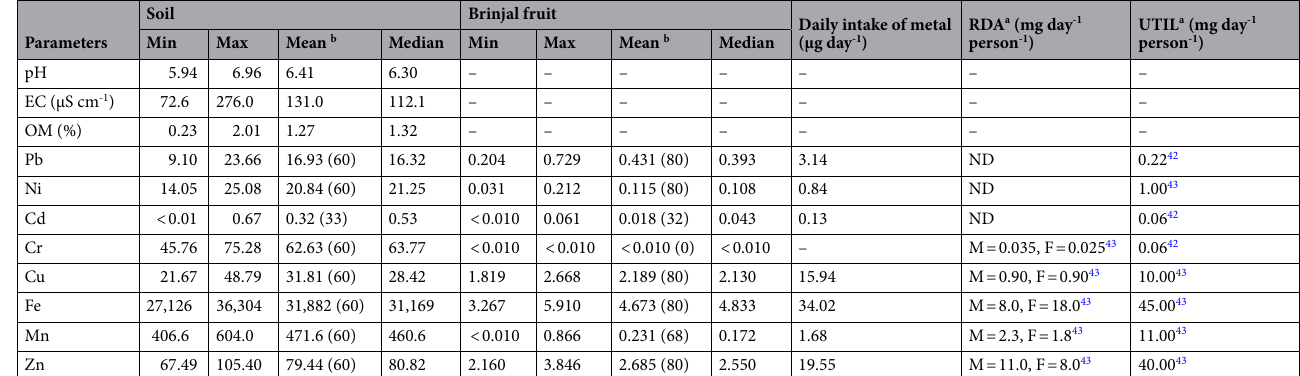
Table 4. Trace metal contents (in µg g -1 ) in soils and brinjal fruits collected from farmers ′ fields of Jamalpur district, Bangladesh along with physicochemical properties of soils, and daily intake and recommended dietary allowances of nutritionally important elements. a Life stage group 19–50 years; RDA recommended dietary allowances, UTIL upper tolerable daily intake level, ND not determined, M males, F females. b Value in parenthesis indicates the number of the samples that were above the limit of detection